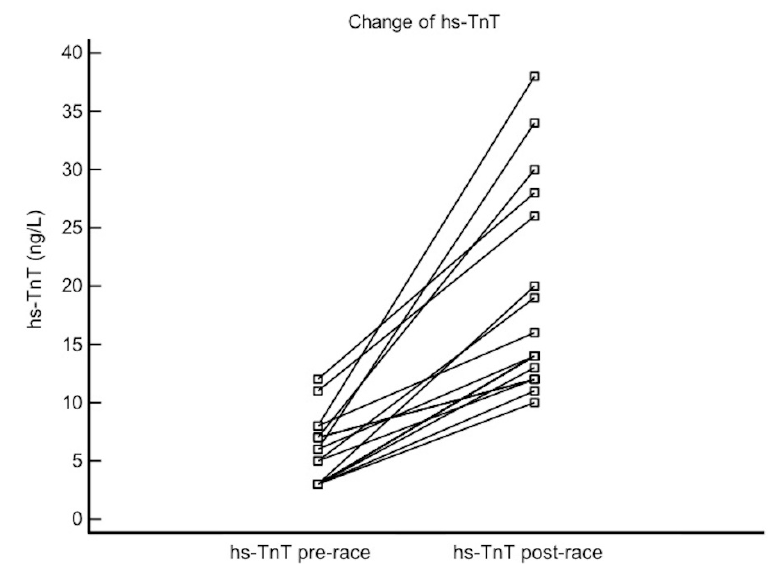
Figure 1. High-sensitivity troponin T (hs-TnT) concentration before and immediately after the end of running.